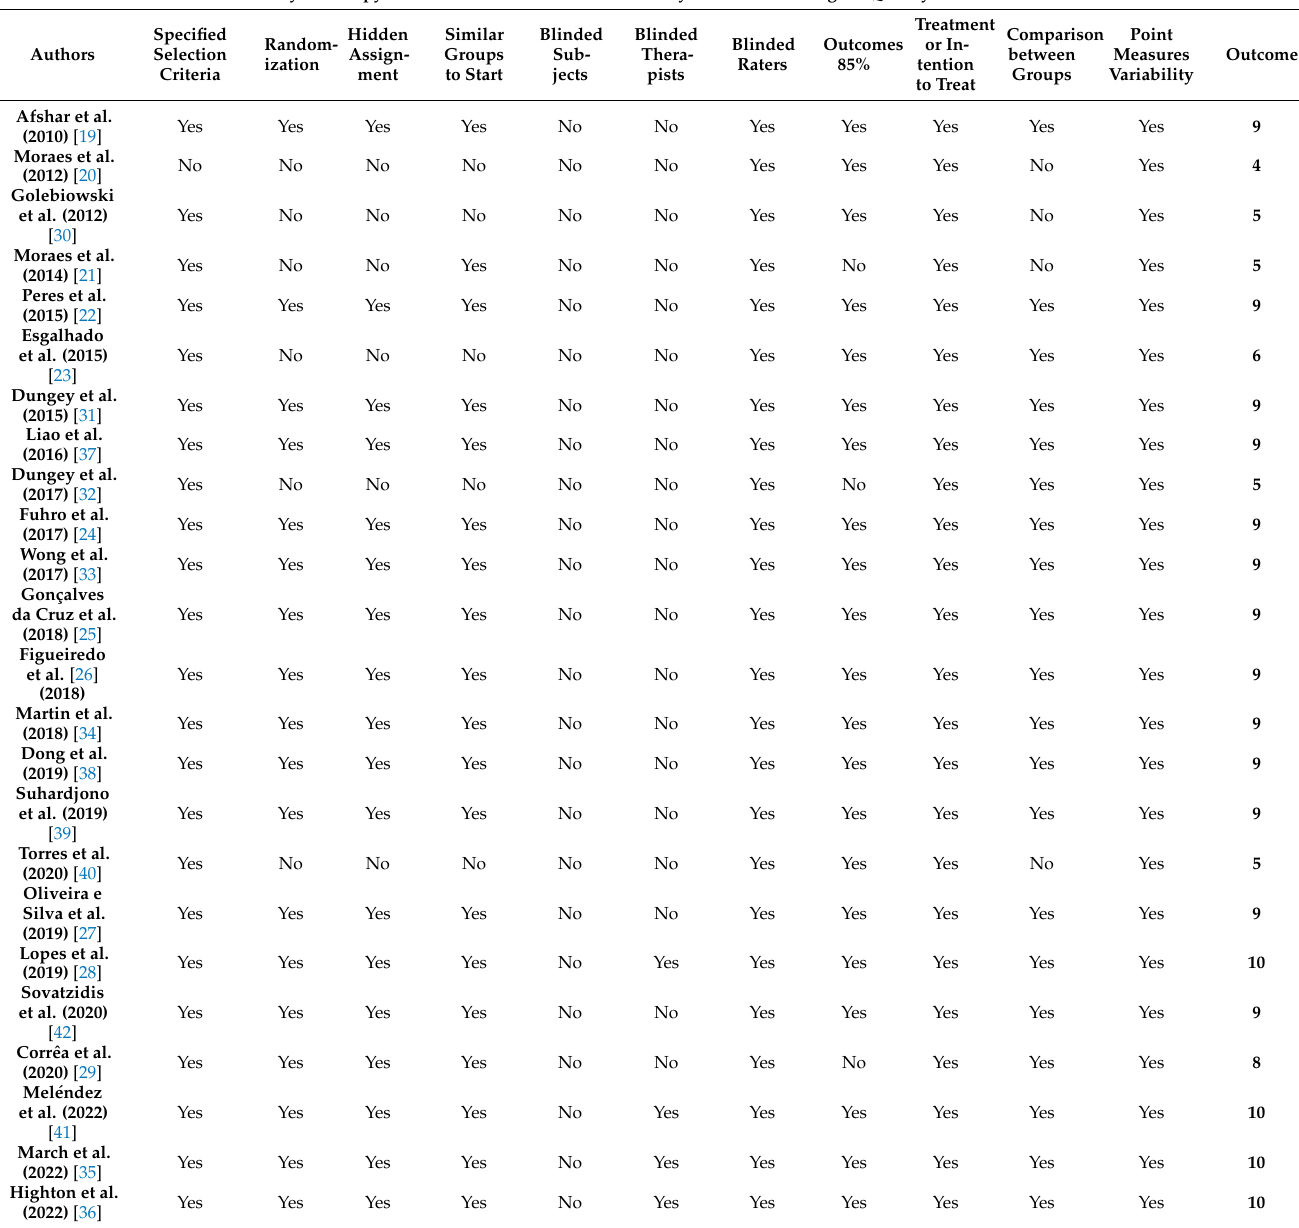
Table 2. Methodological quality evaluation of the clinical trials using the PEDro Scale for assessing the risk of bias in randomized and non-randomized